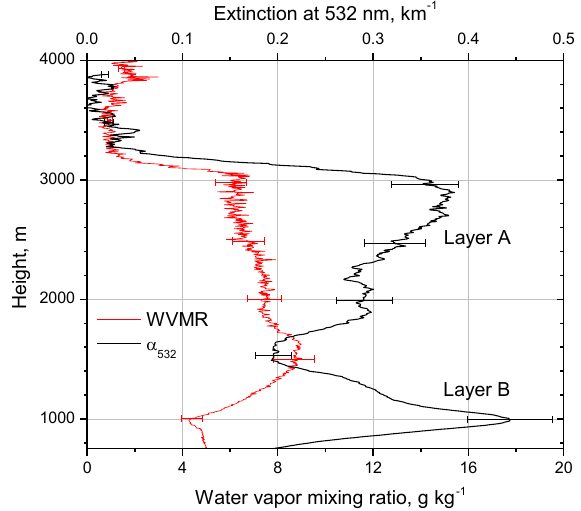
Figure 5. Vertical profiles of particle extinction coefficients at 532nm and water vapor mixing ratio on 16 April 2015. Results are averaged over the 05:00–06:00UTC temporal